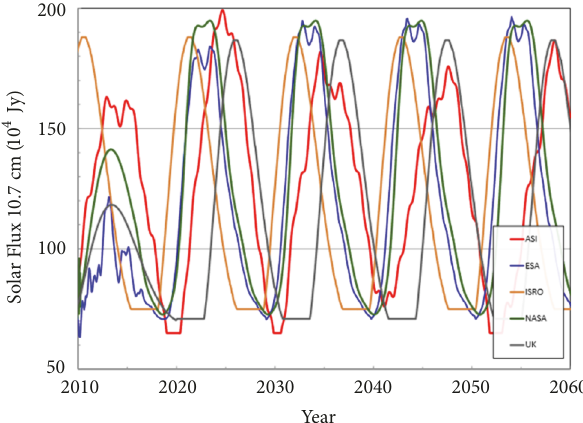
Figure 13: Solar flux projections used in IADC comparison study.